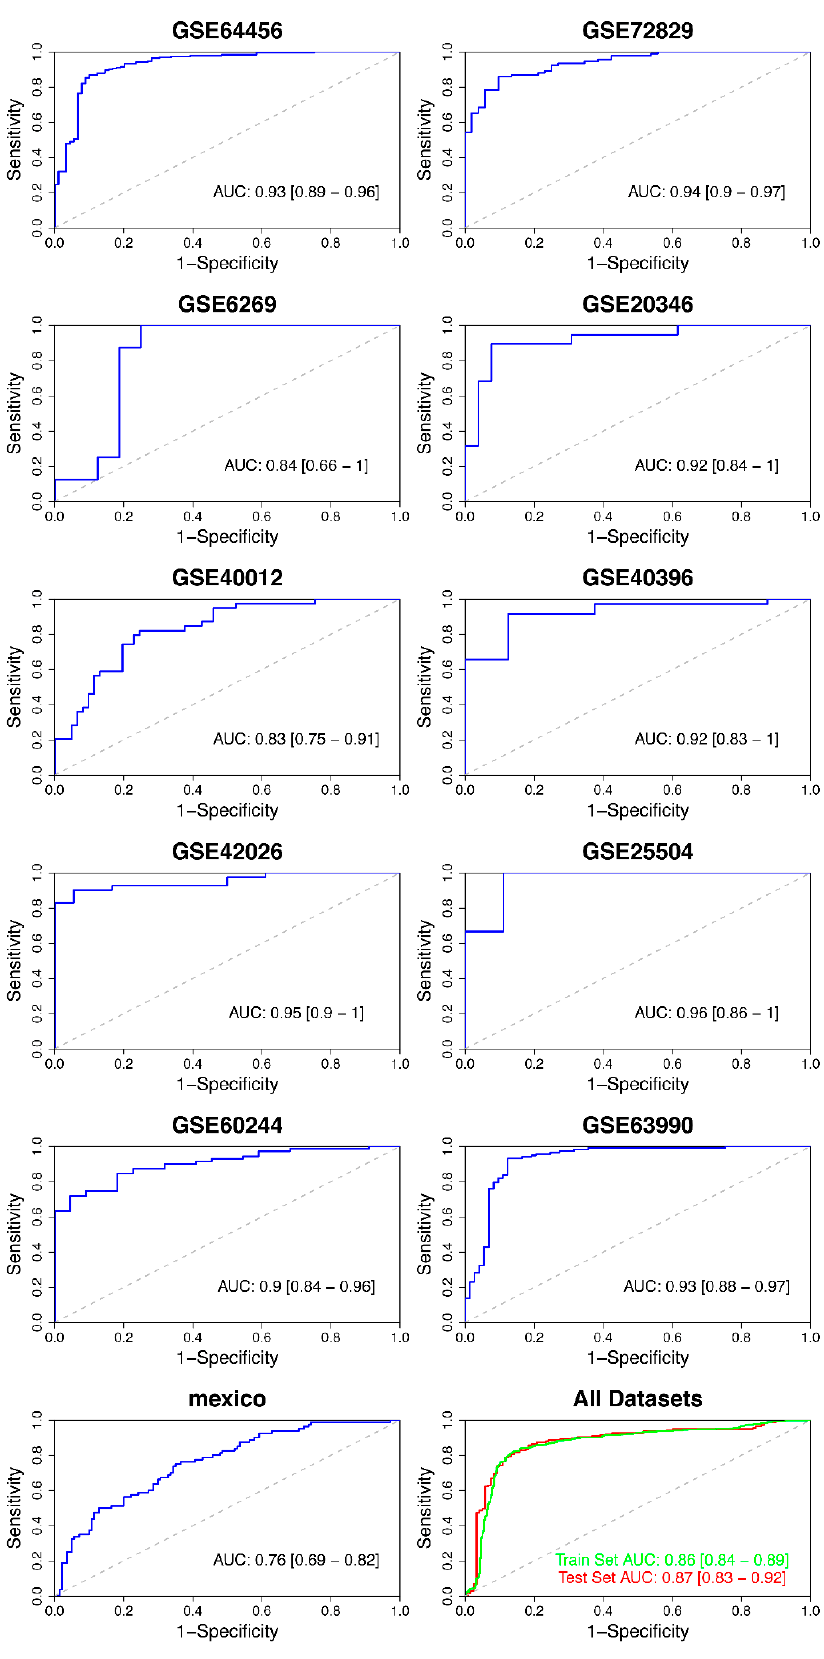
Figure 2. Evaluation of the 3-transcript signature performance in individual studies as well as in the training and test cohorts. AUC values and 95% CI are provided.